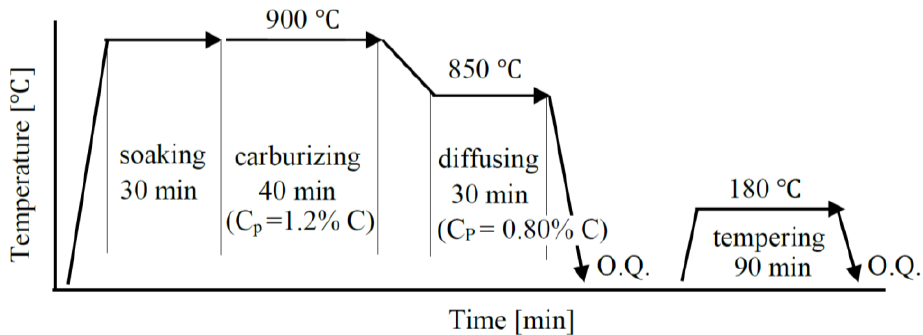
Figure 1. Dimensions of smooth and notched specimens for ( a ) torsional and ( b ) rotational bending fatigue tests. K t and K b are stress concentration factors for torsion and bending. All dimensions are in mm.